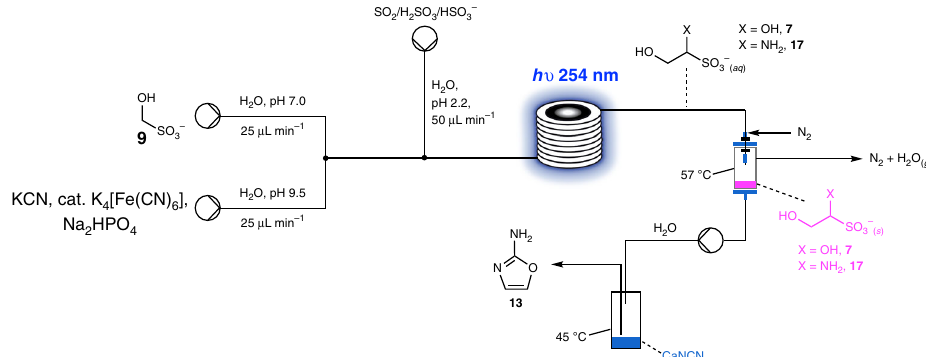
Fig. 8 Flow chemistry set-up starting with HMSA 9 . This arrangement was designed to mimic the second variant of our geochemical scenario (see